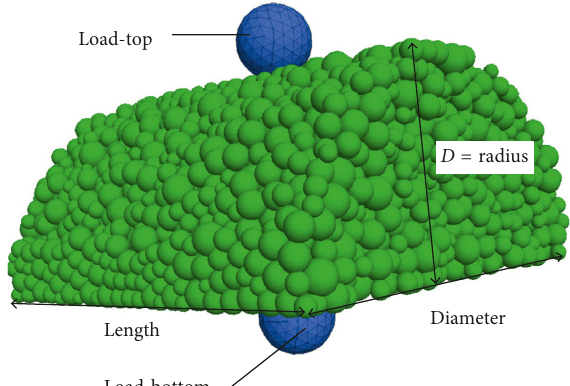
Figure 8: The numerical model of half-cylinder specimens.